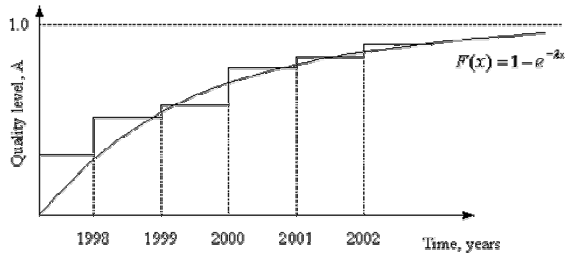
Fig 1. The principles of continuous quality